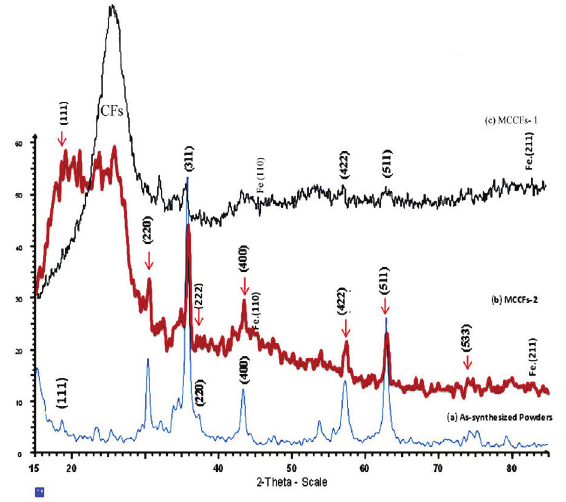
Fig. 1. XRD patterns of Fe carbon fibers prepared at 80 o C (b) and 60 o C